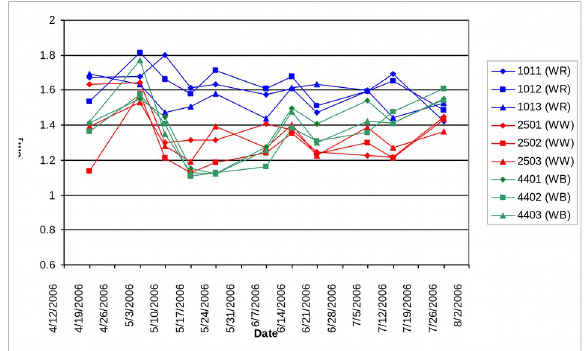
Figure 9. Roughness developing for the sample points 101 (WR), 250 (WW) and 440 (WB).